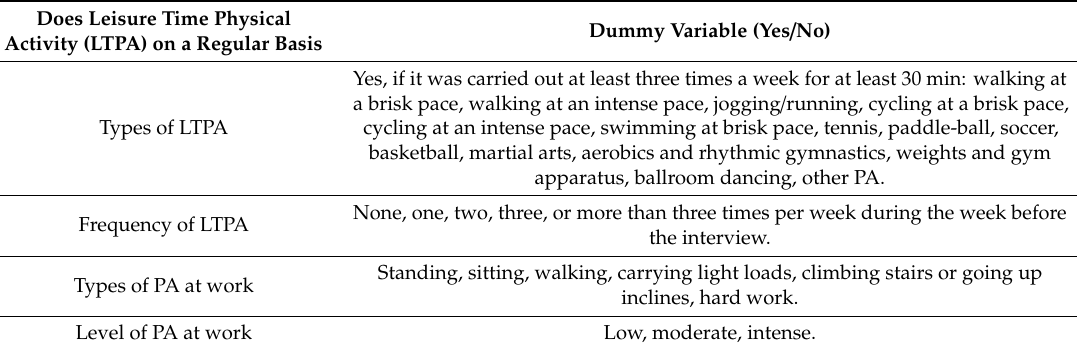
Table 1. Descriptions of PA